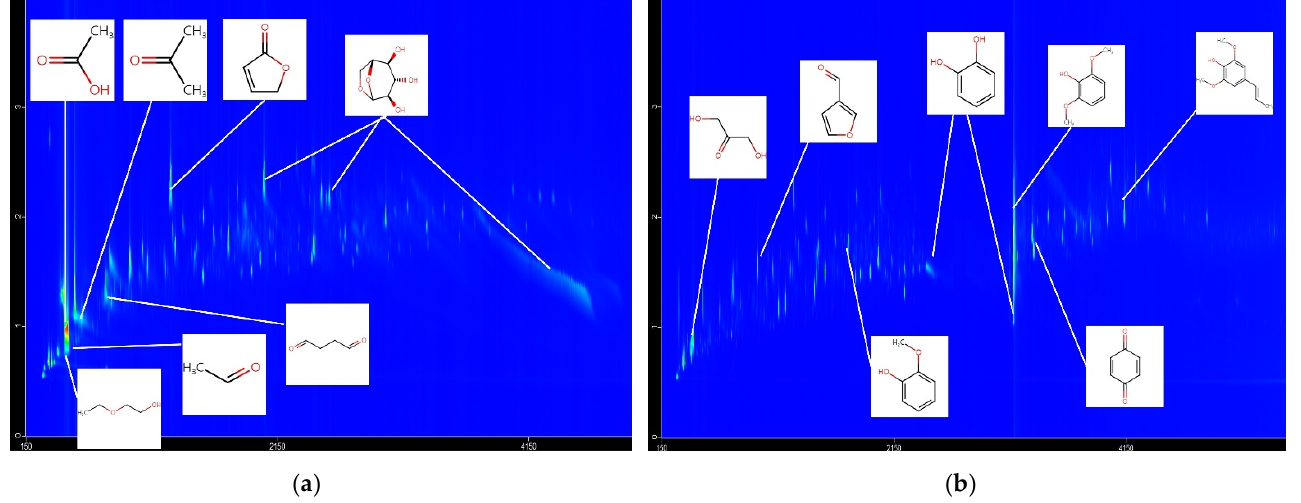
Figure 3 . GC × GC TOF MS chromatogram of first fractionation: ( a ) water phase, and ( b ) oil phase. x = retention time, y = TOF axis.